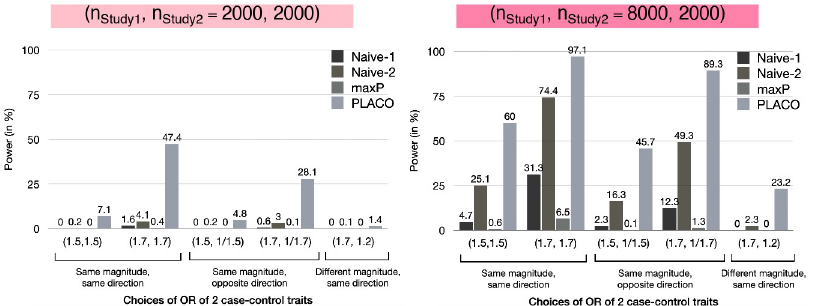
Fig 3. Scenario I: Power of PLACO, maxP and naive approaches at genome-wide significance level (5 × 10 − 8 ) for varying genetic effects of traits from 2 independent case-control studies. Sobel’s approch is excluded from this figure since it has < 1% power across all scenarios. The first naive approach (‘Naive-1’) declares pleiotropic association when p Trait1 < 5 × 10 − 8 and p Trait2 < 5 × 10 − 5 , while the second naive approach (‘Naive-2’) uses a more liberal criterion p Trait1 < 5 × 10 − 8 and p Trait2 < 5 × 10 − 3 . Each study either has 1, 000 unrelated cases and 1, 000 unrelated controls, or Study 1 has 4 times sample size as Study 2, where Study 2 has 1, 000 unrelated cases and 1, 000 unrelated controls.